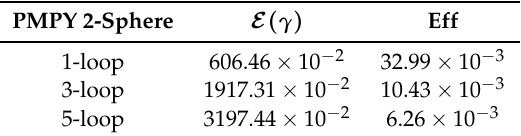
Figure A2. Geodesic strokes of PMPY 2-sphere swimmers showing multi loops. ( a ) The γ -paths of the geodesic strokes of the PMPY 2-sphere swimmer, with X ( γ ) = 0.2 and ε = 0.2. ( b ) The geodesic stroke trajectories from ( a ). Table A3. Energy dissipation E ( γ ) and efficiency Eff of geodesic strokes of the PMPY 2-sphere swimmer, with X ( γ ) = 0.2, ε = 0.2.